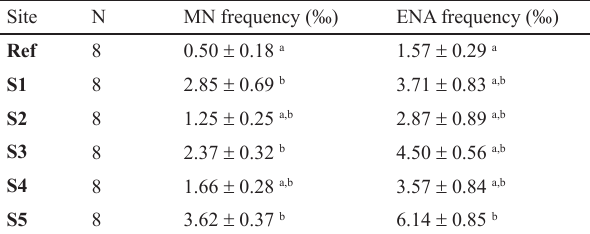
Table 3. Frequency of micronuclei (MN) and other nuclear abnormalities (ENA) in erythrocytes of A. altiparanae , taking into account the total number of fish (N) analyzed from the reference site (Ref) and from each site located along Água das Araras stream (S1, S2, S3, S4, and S5). Different letters indicate significant differences between sites (P <